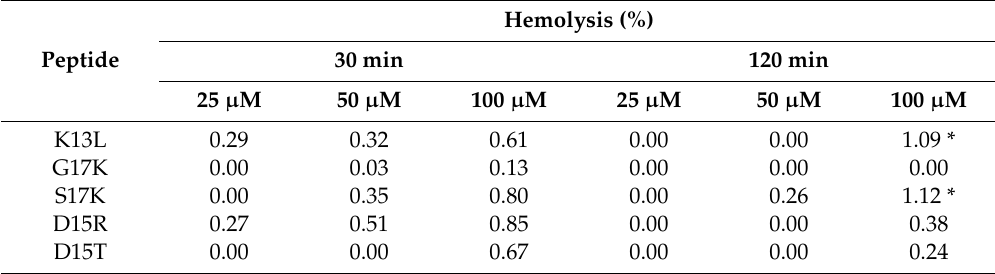
Table 3. In vitro hemolytic activity of the investigated peptides.